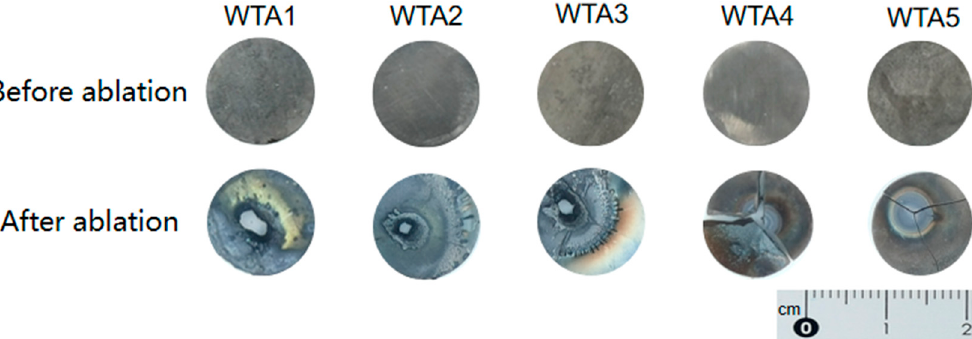
Figure 5. Macroscopic topography of WTA1–WTA5 composites before and after ablation. The mass ablation rates of W-TaC composites were collected in Table 3. The addition of TaC has improved the ablation resistance of the W-TaC composites. The tested value reduced from 0.0918 g · s − 1 in WTA1 to 0.0678 g · s − 1 in WTA3. In the composite WTA4, it declined to a negative value of − 0.0126 g · s − 1 . The negative values are mainly due to the thermal shock damage of WTA4 and WTA5 at the moment of ablation, but the ablation was not continued. In the very short time from the beginning of ablation to the thermal shock damage, a small amount of microstructure in the ablation center is oxidized, which leads to the increase in the mass of the composites after ablation. The ablation rate was higher than that (0.0048 g · s − 1 ) of the reactive sintered W-30 vol%TaC composite ablated under an